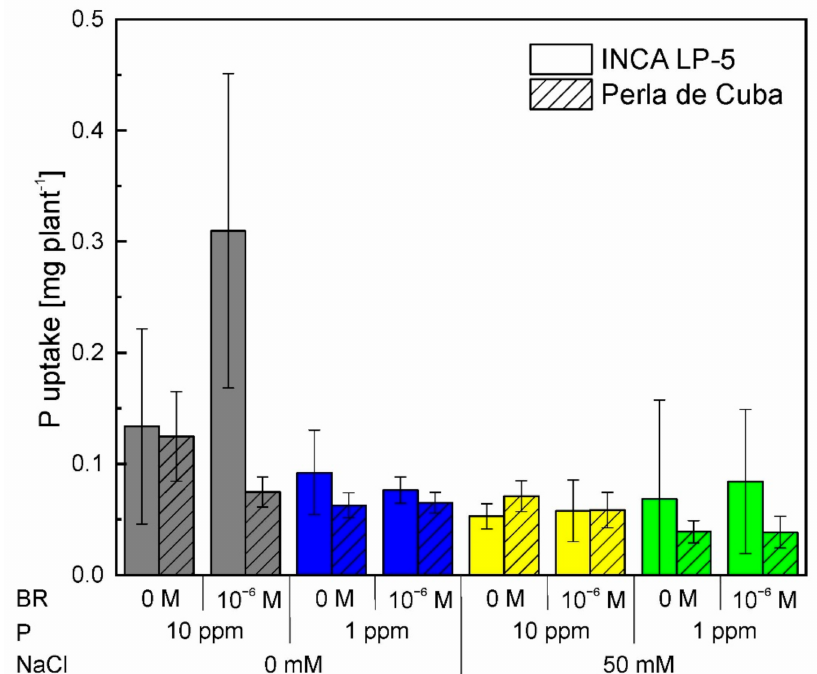
Figure A1. Phosphorus uptake of the two rice cultivars INCA LP-5 and Perla de Cuba after growth for three weeks in mini-rhizotrons treated with phosphorus (P) depletion, NaCl or both and pre-treated with 24-epibrassinolide (BR). Mean ± SD, n = 5.